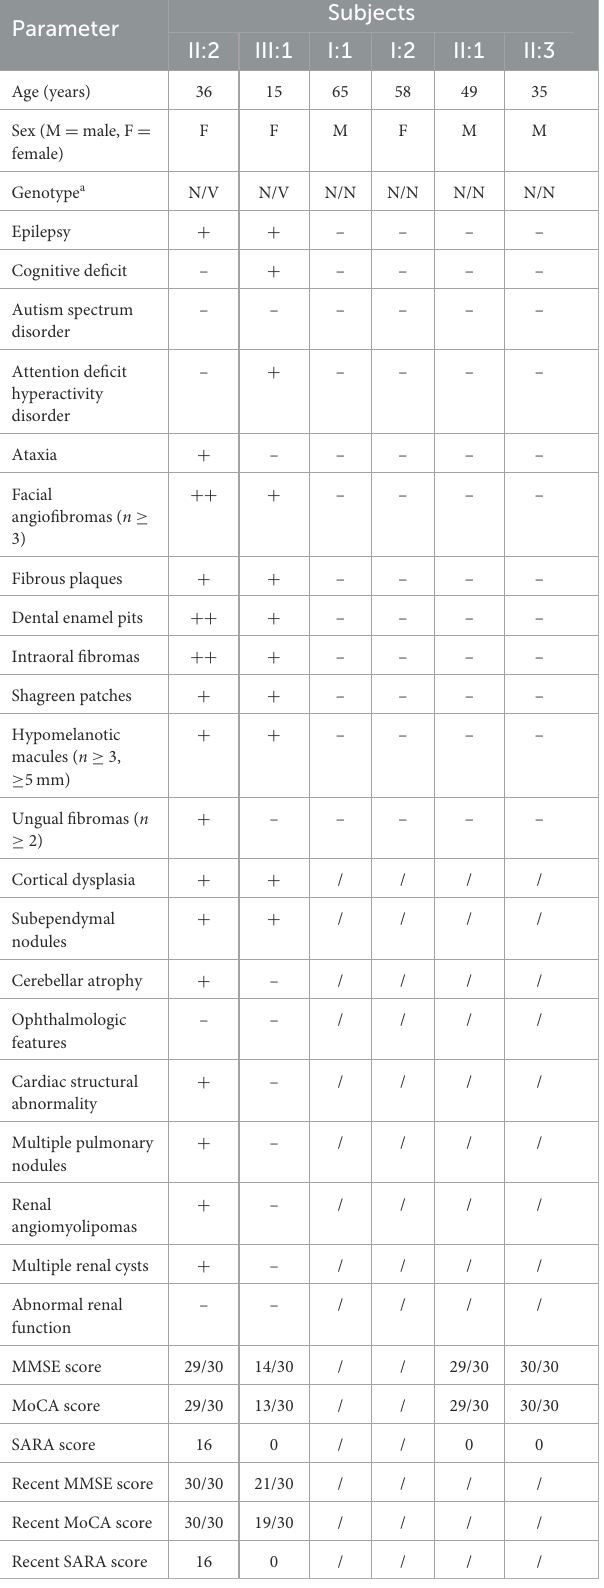
TABLE 1 Clinical and genetic characteristics of members in the TSC-afflicted